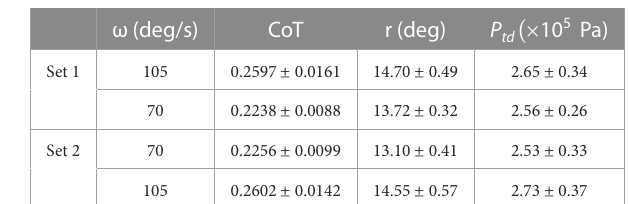
TABLE3 Steady-statestatisticsofFigure 6.